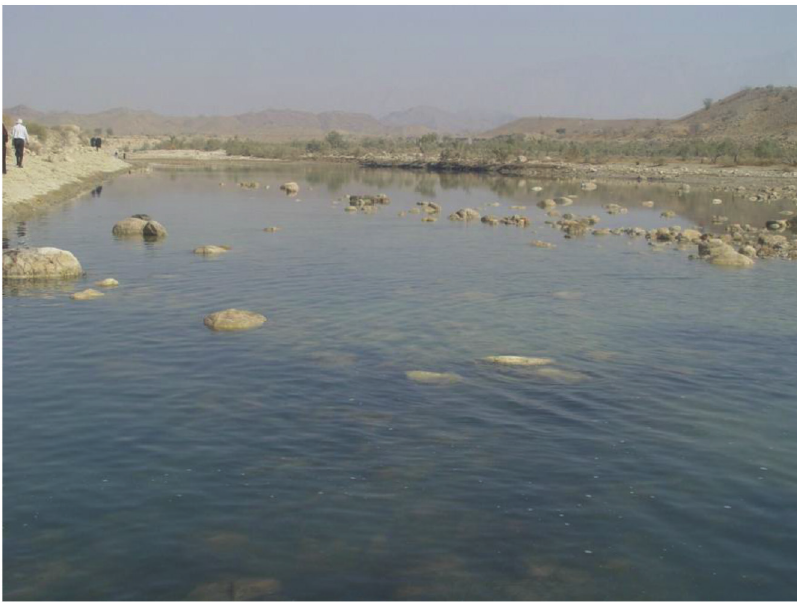
Figure 9. Habitat of Iranocichla persa , Khorgo hot spring, Shur River drainage, or restricted to posterior scale margins on upper flank above a horizontal line between pectoral-fin origin and posterior anal-fin base or a bit above that line. Below that line, iridescent spots and blotches on posterior scale margin roundish or ovoid, often irregu- larly shaped. On caudal peduncle and body behind a vertical line between last dorsal- fin spine and anal-fin origin, white spots narrow, restricted to posterior scale margin or along complete free scale margin, forming a reticulate pattern on caudal peduncle. Some individuals with irregularly x-shaped white blotches on anterior flank, roundish or ovoid on belly and comma-shaped, short vermiculate or roundish on dorsal and posterior flank. Dorsal fin with orange margin in most nuptial males, black in others. Dorsal fin rays hyaline, grey or black. Spines, membranes with white roundish or verti- cally elongated blotches, some fused to forward slanted narrow bars. Caudal fin grey or black with very clear white spots making almost wavy bars or stripes on the caudal fin. Anal fin grey with black distal anterior edge, with a few white, roundish, elongate or comma shaped blotches, most prominent on proximal and posterior parts of anal fin, absent on distal and anterior parts. Pelvic fin grey, light blue or black with few or no white spots or blotches. Pectoral fin hyaline or with black rays.